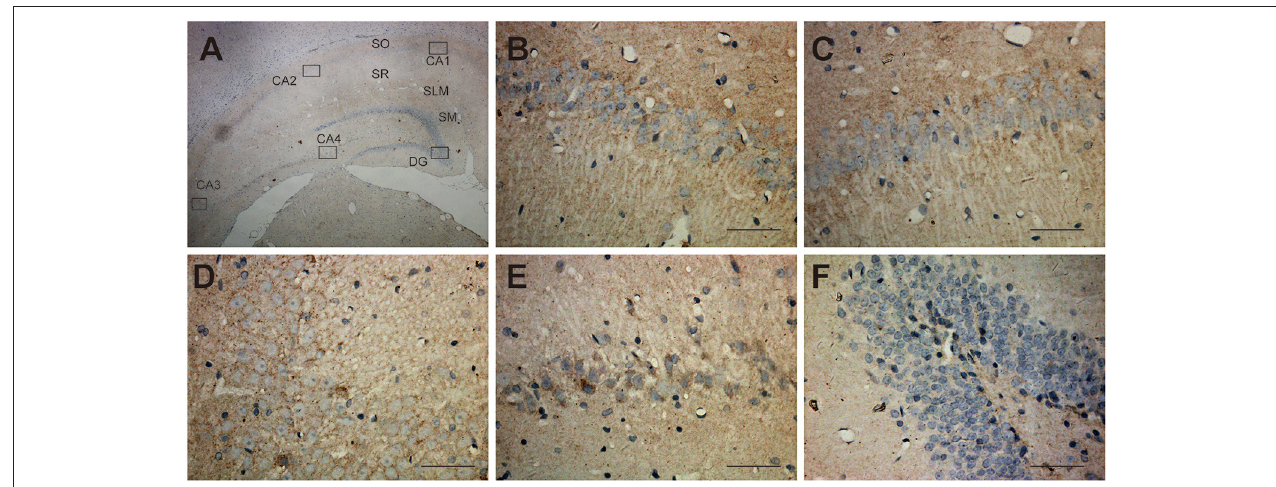
FIGURE 3 | Distribution of UT-B in the hippocampus detected by immunohistochemistry. (A) UT-B is widely distributed throughout the hippocampus. (B–E) High magnification view of CA1-4: UT-B signals were not significantly observed at CA1 or CA2 but were gradually enhanced by astrocytes at CA3 and CA4. (F) High magnification view of dentate gyrus: UT-B signals by astrocytes in the granule cell layer in the dentate gyrus. SO, stratum oriens; SR, stratum radiatum; SLM, stratum lacunosum-moleculare; SM, molecular layer; UT-B, urea transporter B. Scale bar, 200 µ